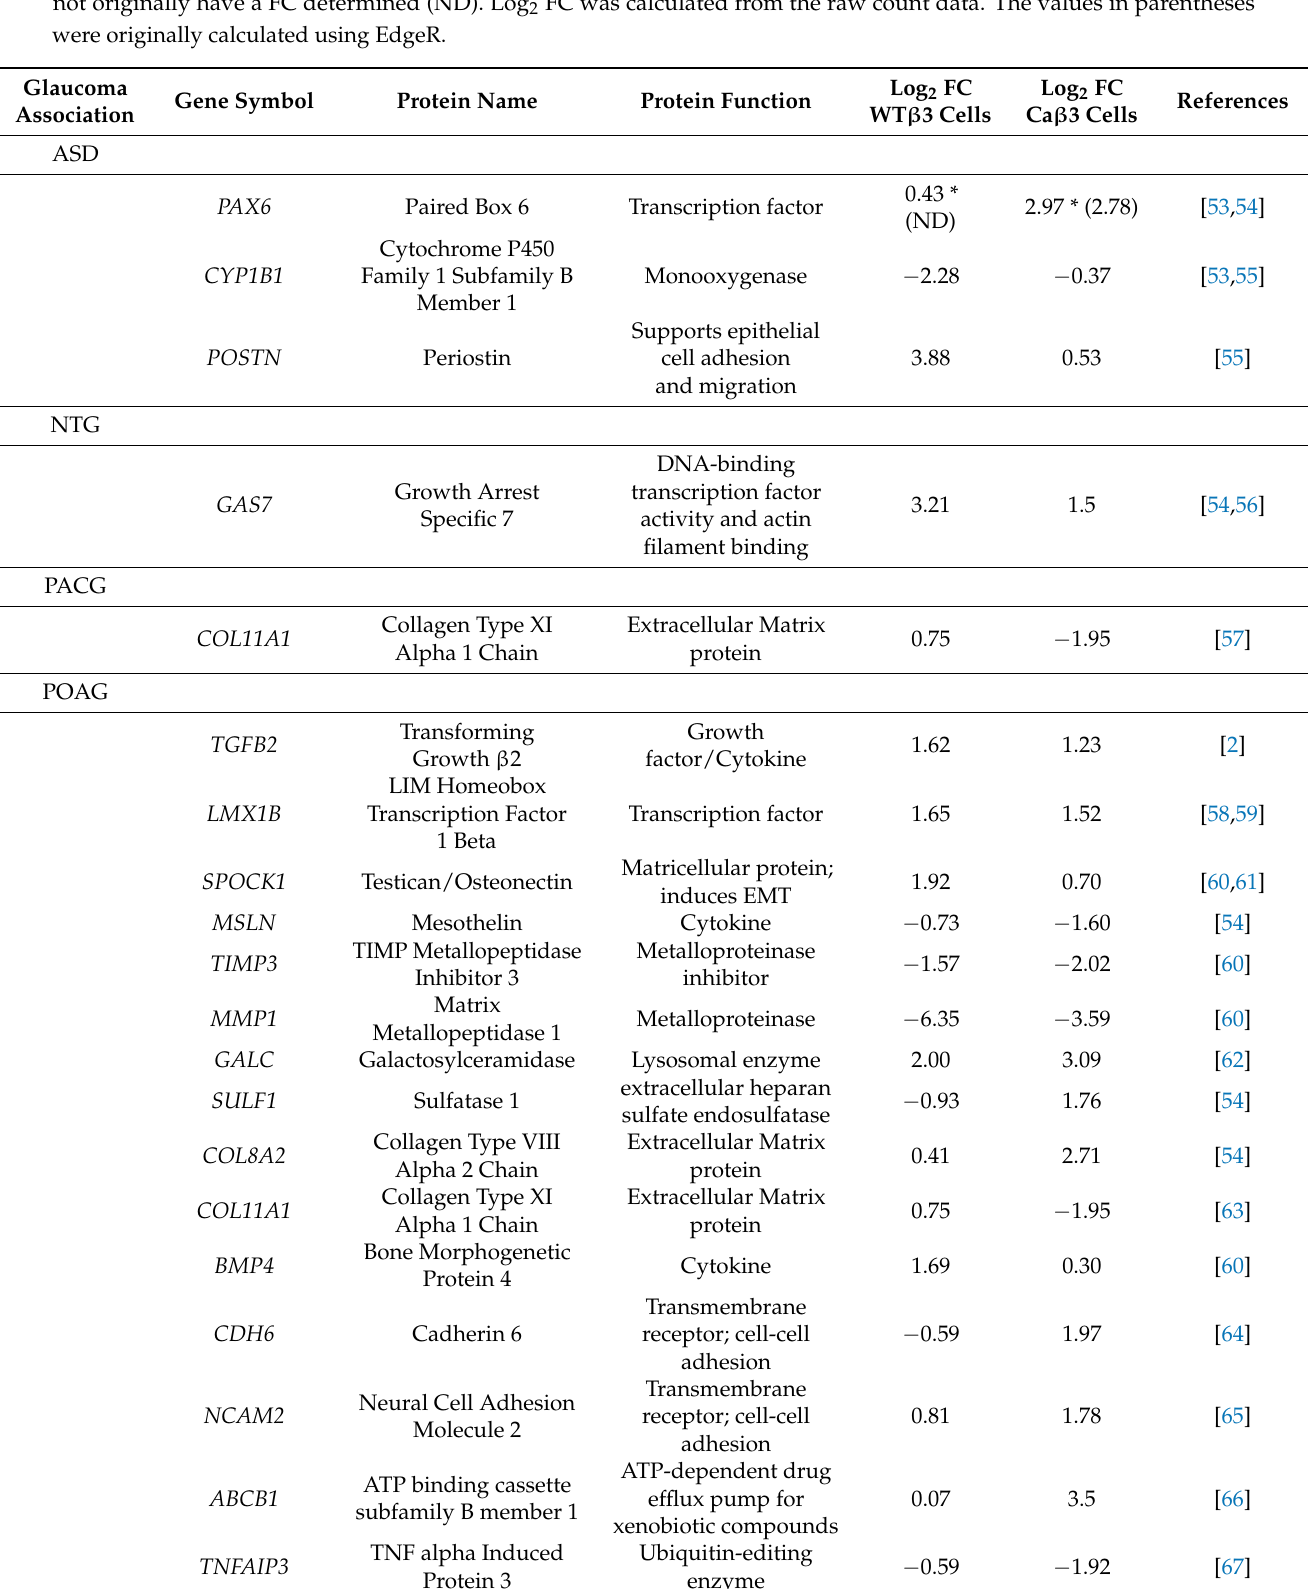
Table 2. Differentially expressed genes in WT β 3 and/or CA β 3 cells that are associated with glaucoma. Except where noted by *, Log 2 FC values were reported in DGE analysis using EdgeR. * Genes that were filtered out due to low abundance did not originally have a FC determined (ND). Log 2 FC was calculated from the raw count data. The values in parentheses were originally calculated using